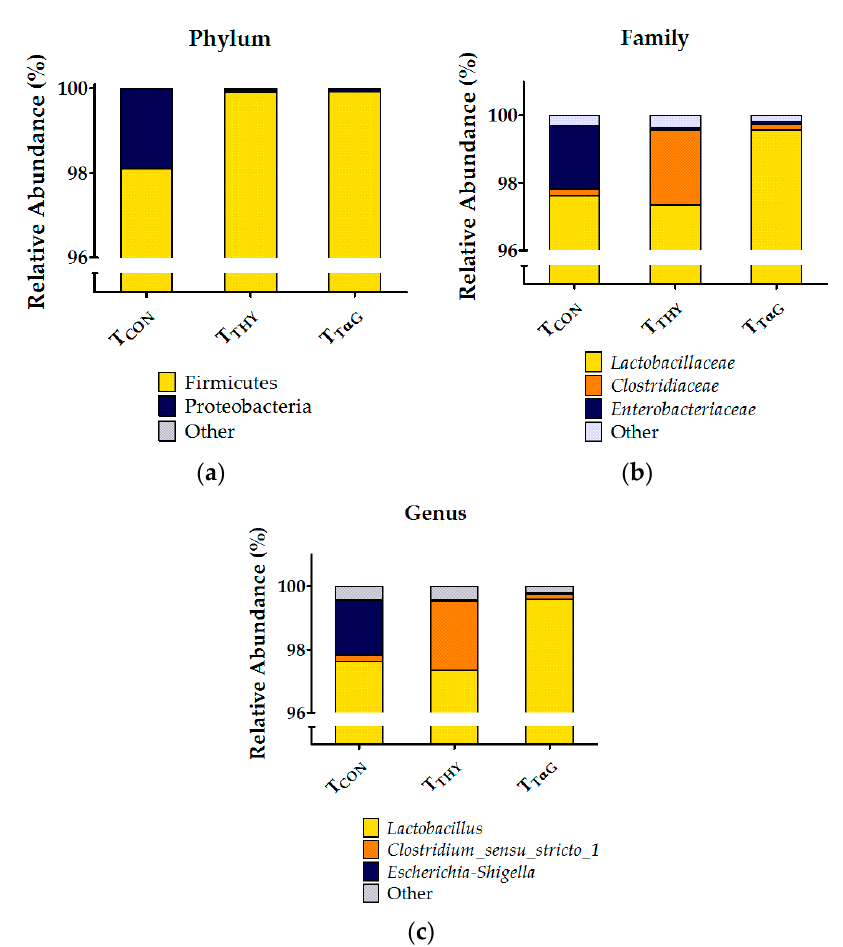
Figure 3. The cumulated relative abundances of the identified taxa at the ( a ) phylum, ( b ) family, and ( c ) genus levels in the small intestinal contents of the last 25% of the total length of piglets fed a basal diet (T CON ) supplemented with 3.7 mmol / kg DM thymol (T THY ) or thymol α -D-glucopyranoside (T T α G ).